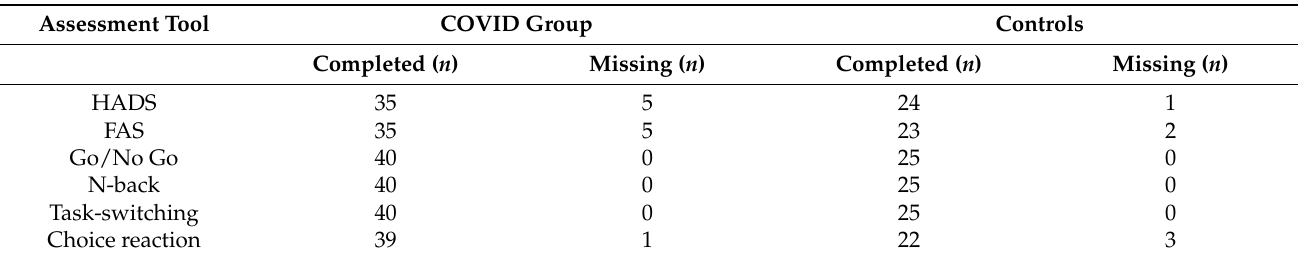
Table 2. Information on missing data by